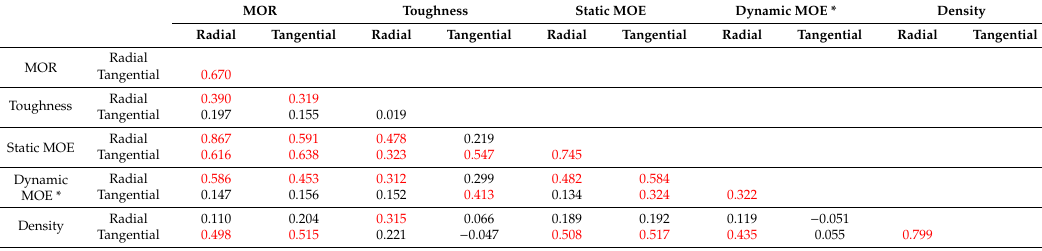
Table A6. Values of Correlation Coe ffi cients Between Given Quantities for Beech Wood.